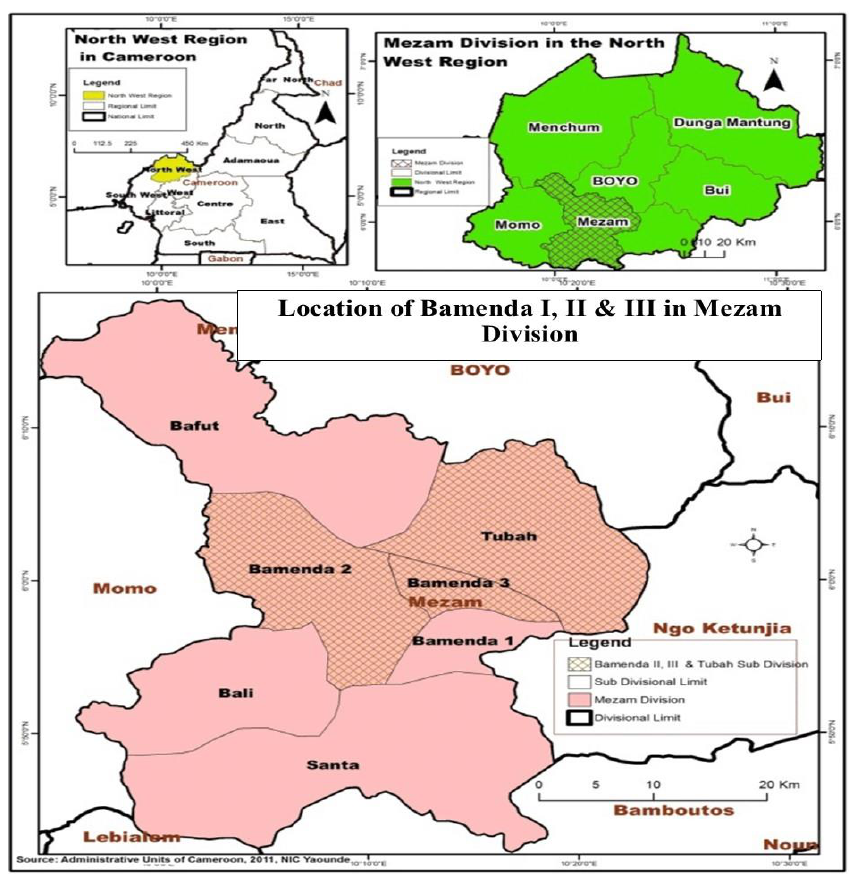
Figure 2. Map of Bamenda in the North-West Region of Cameroon. source [29]